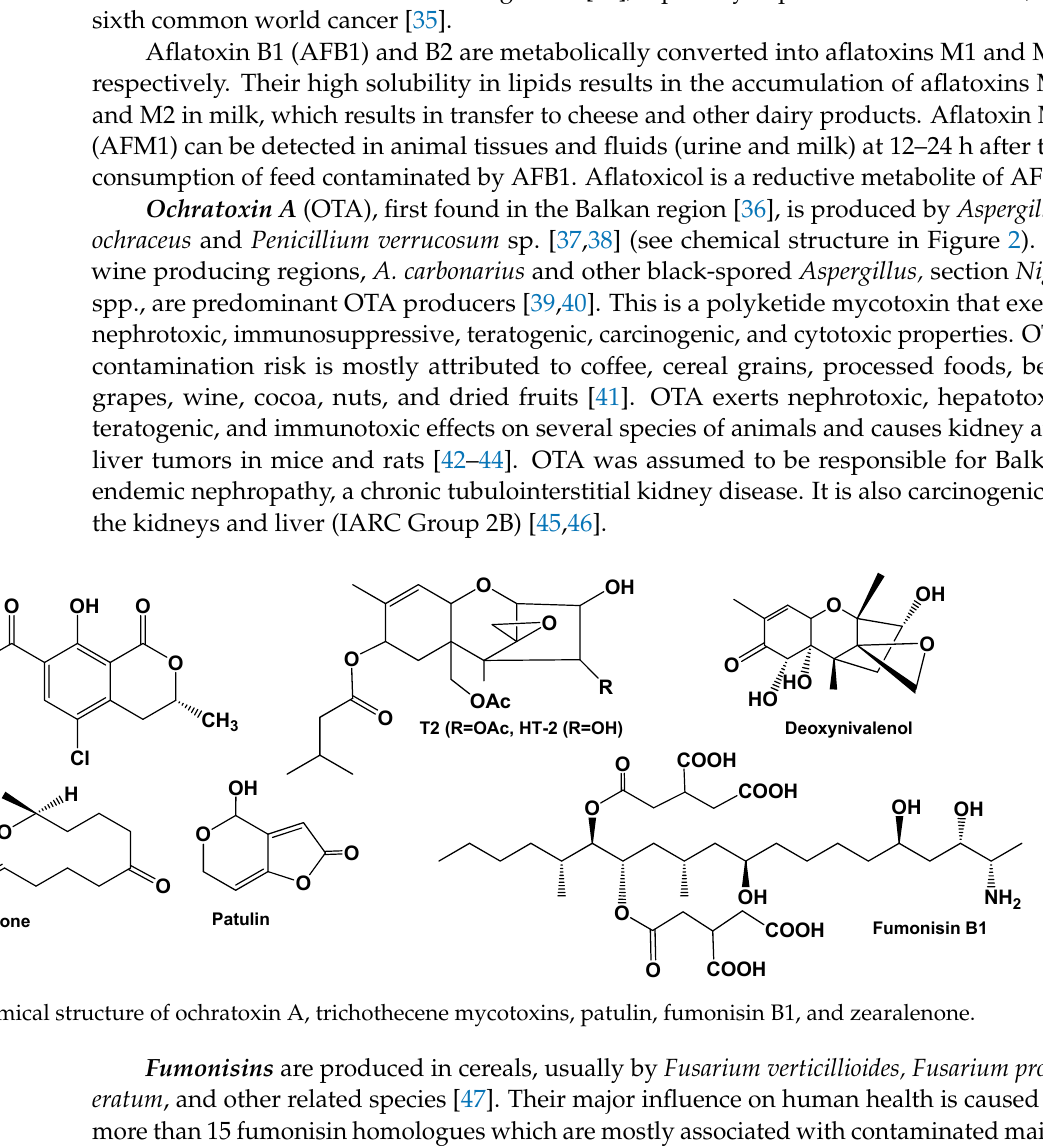
Figure 1. Chemical structure of aflatoxins.